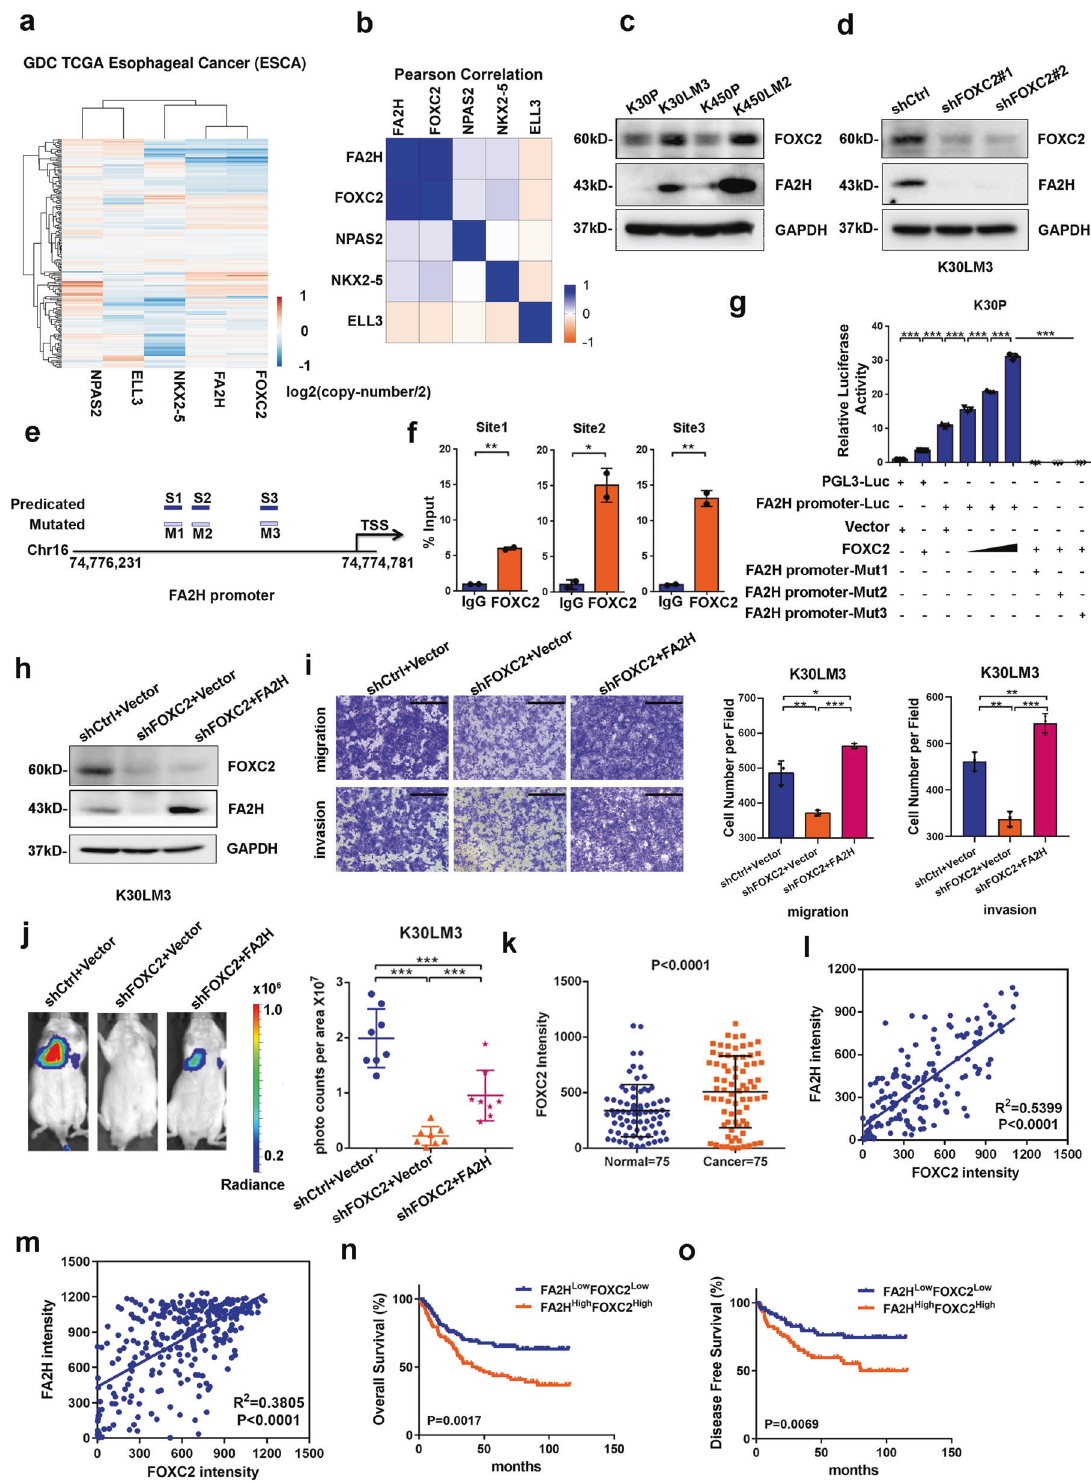
of gastric and colorectal cancer cells. 15,16 On the other hand, signi fi cantly changed lipids from FA2H -depleted ESCC cells were distinct from those described in gastric and colorectal cancer cells with enforced FA2H expression. Thus, the various functions of FA2H may result from its expression and catalytic products, which are determined by distinct tissue contexts.